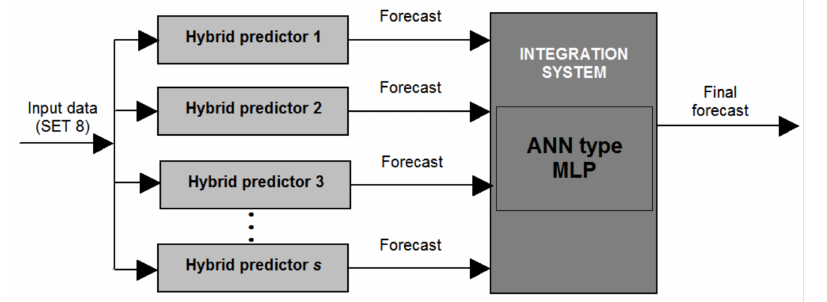
Figure 11. General structure of MLP as an integrator of ensemble of predictors based on hybrid